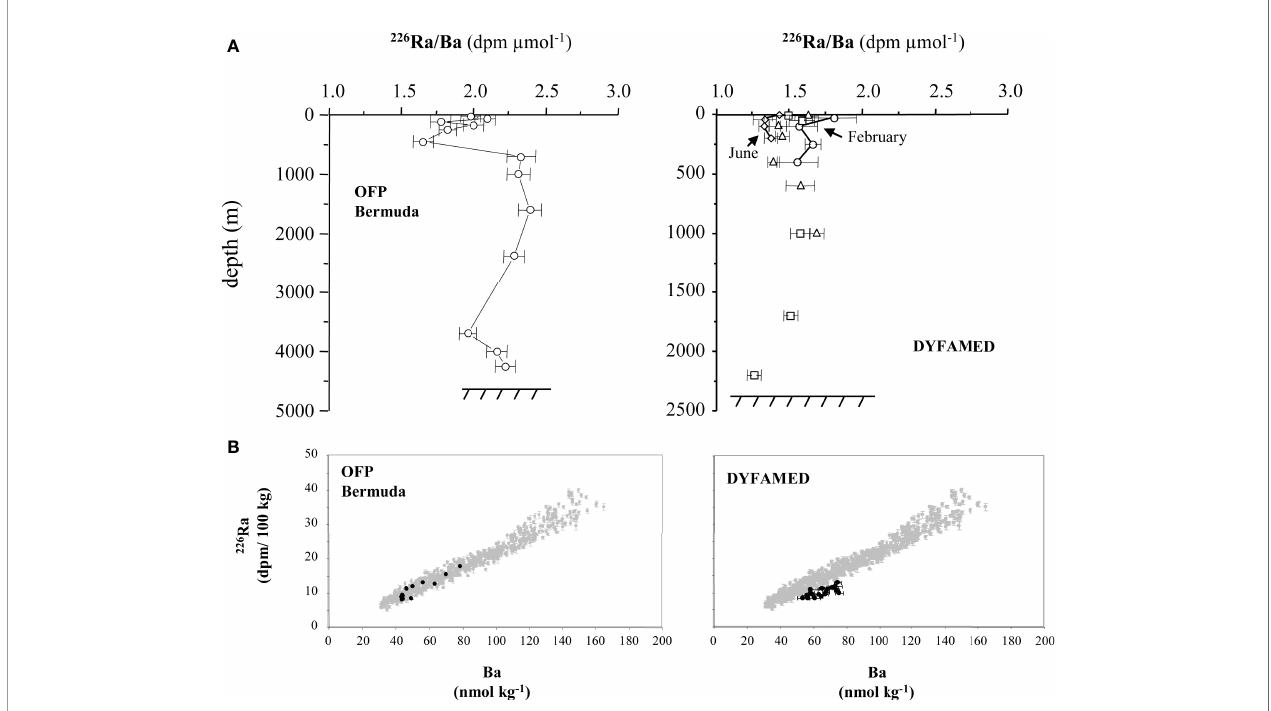
FIGURE 10 | Vertical pro fi les of 226 Ra/Ba ratios reported in seawater in other oceanic basins by previous studies: Sargasso Sea, Atlantic Ocean (van Beek et al., 2007) and Mediterranean Sea (van Beek et al., 2009) (A) . The relationship between Ba and 226 Ra found at these stations is also compared to the Ba- 226 Ra relationship reported from the GEOSECS program (B)